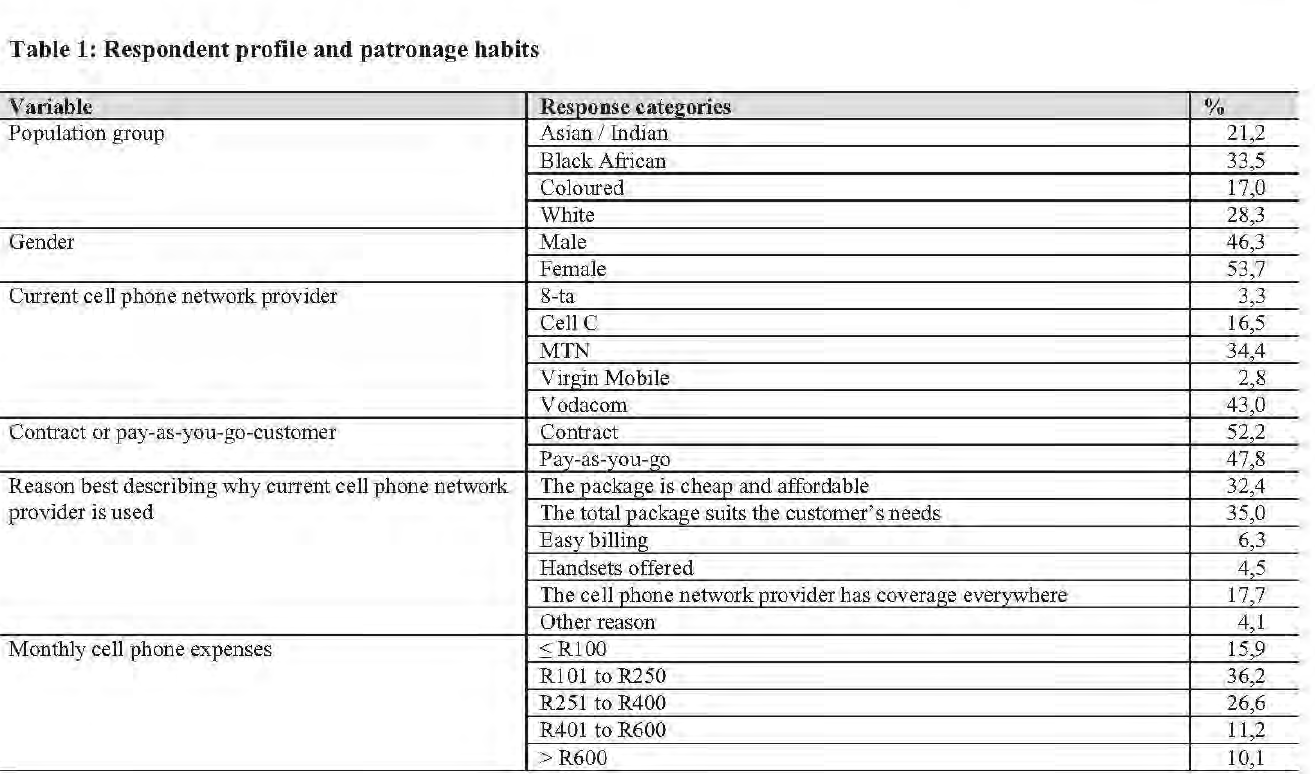
Table 1: Respondent profile and patronage habits